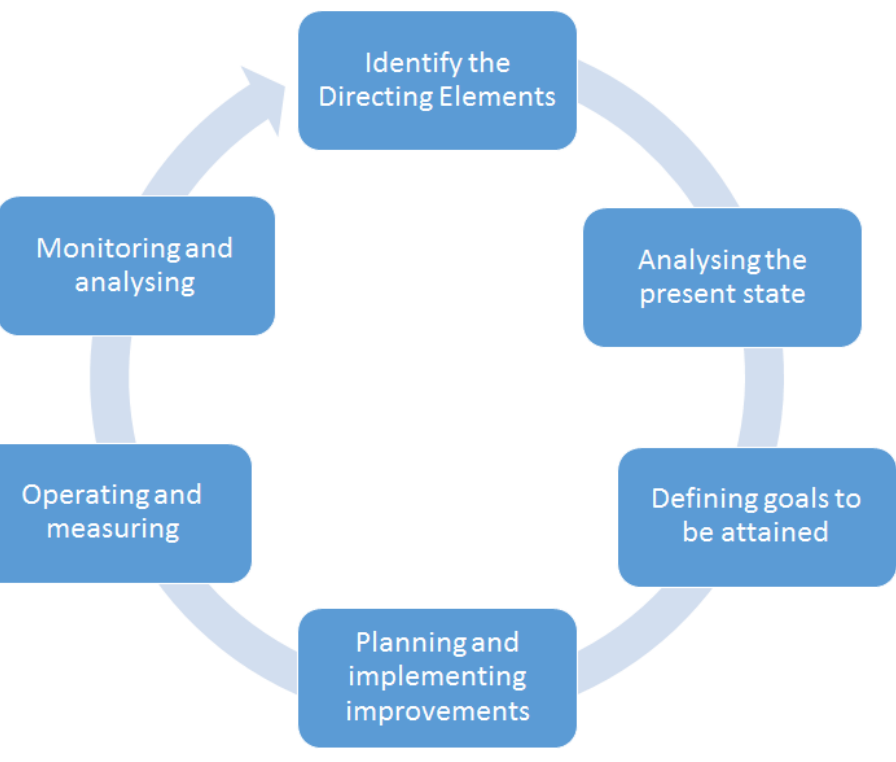
Figure 7. Continuous improvement approach [21],